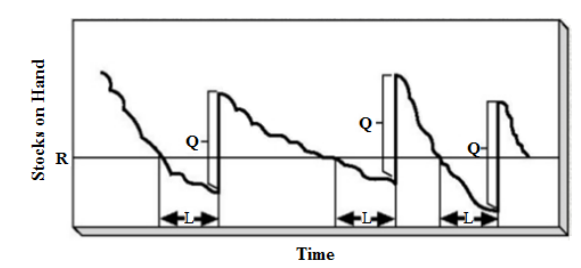
Figure 2: Q-System for the inventory management [11]. Where: L- delivery time, Q-order quantity, R-signal stocks